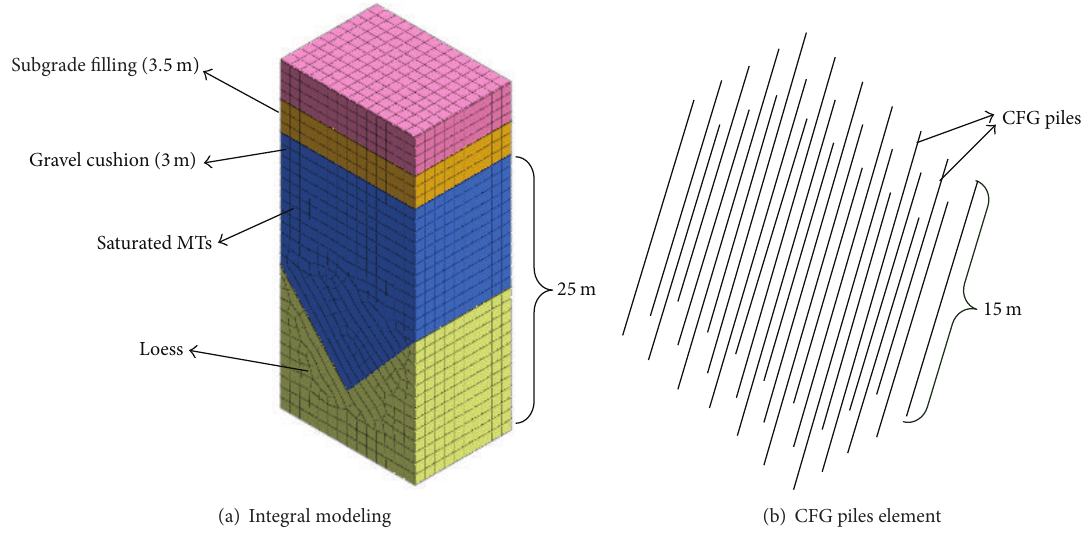
Figure 8: FE modeling of composite foundation and pile element.